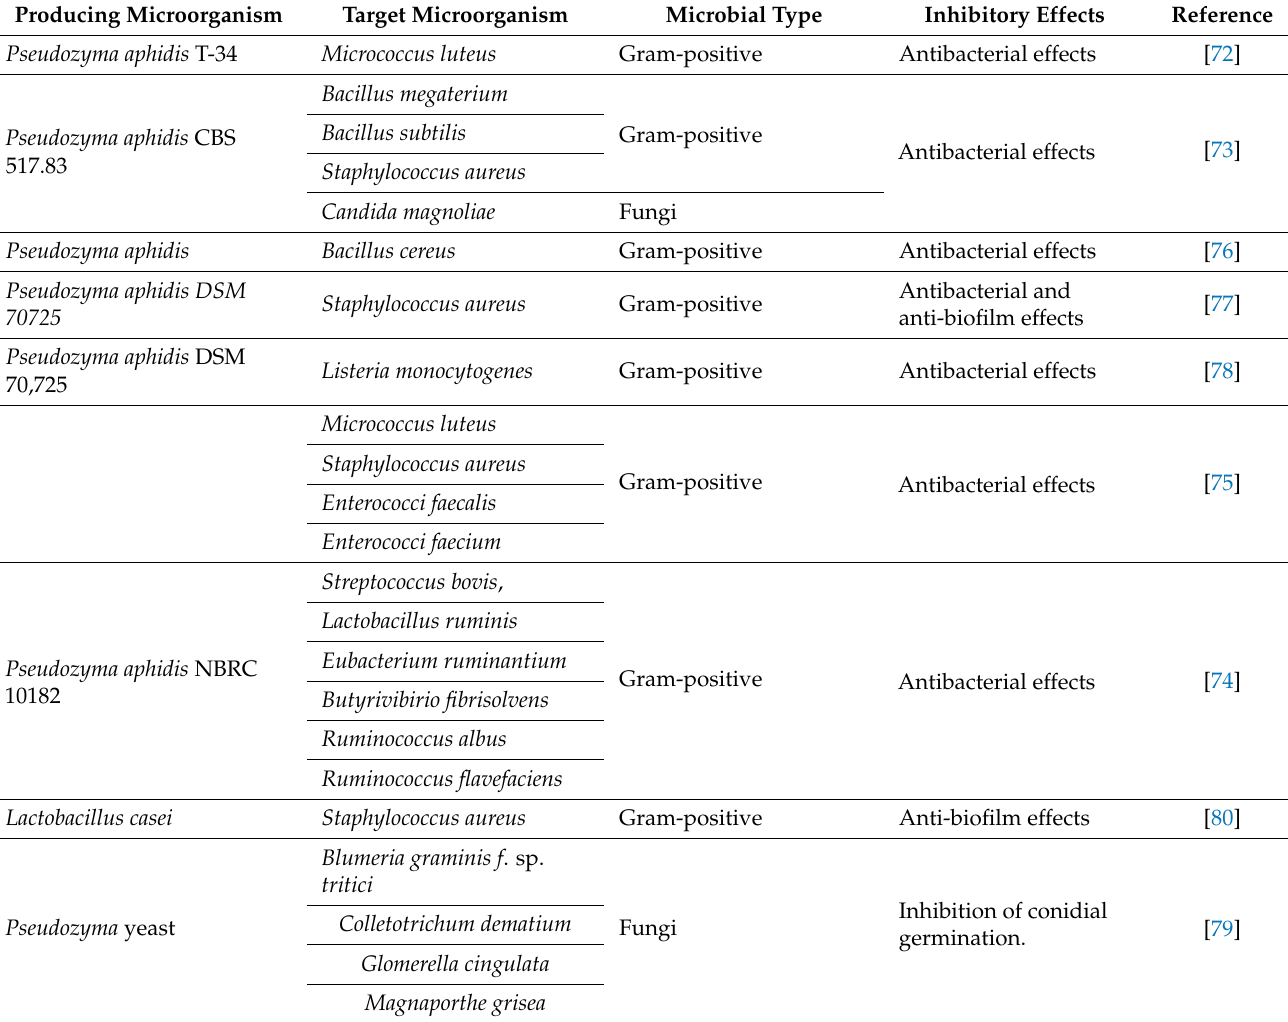
Table 3. Antimicrobial effects of mannosylerythritol